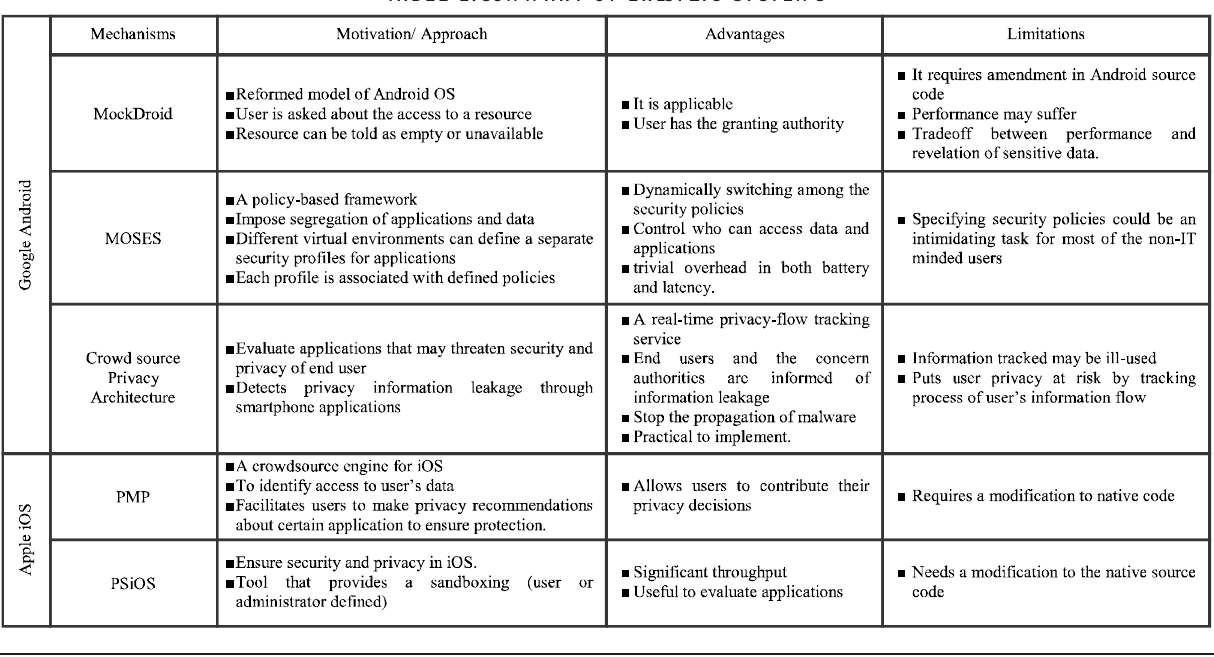
TABLE 2. SUMMARY OF EXISTING